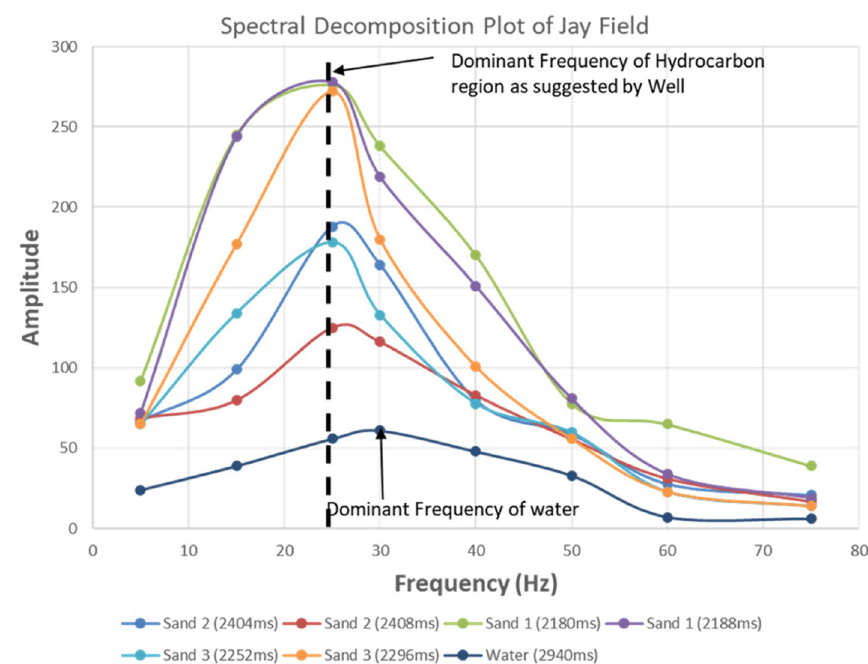
Fig. 17 Plot of amplitude against frequency at different frequency spectra on each time slice